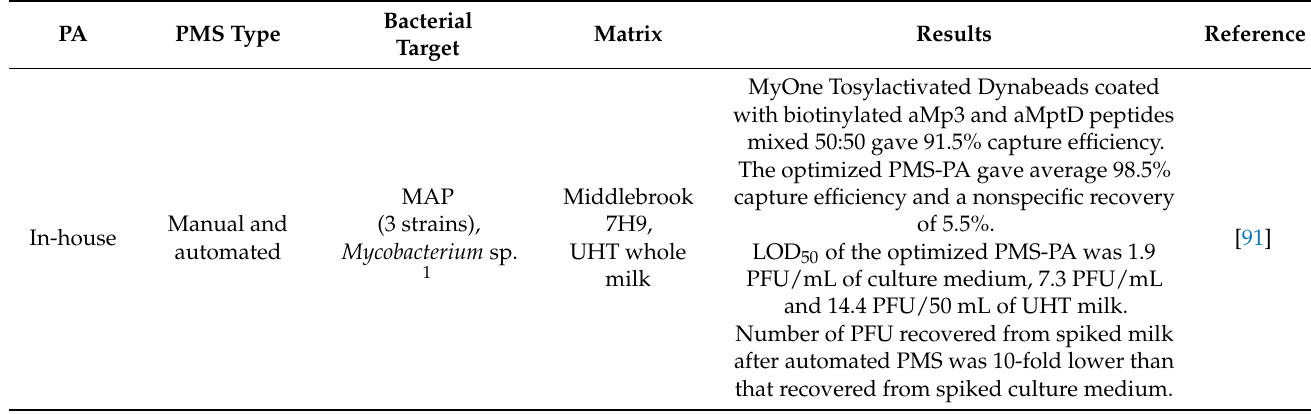
Table 5. Optimization and evaluation of peptide-mediated magnetic separation in combination with phage amplification assay for the detection of mycobacteria using artificial contamination of samples.